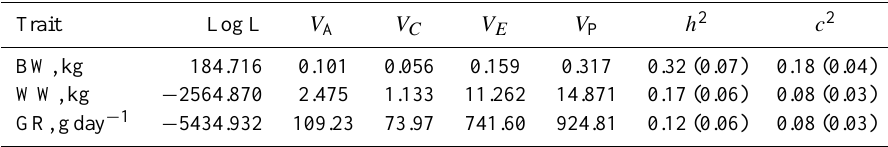
Table 5. Estimates of variance components and genetic parameters from a univariate analyses with both sexes included and with fitting of a fixed effect of lamb sex.